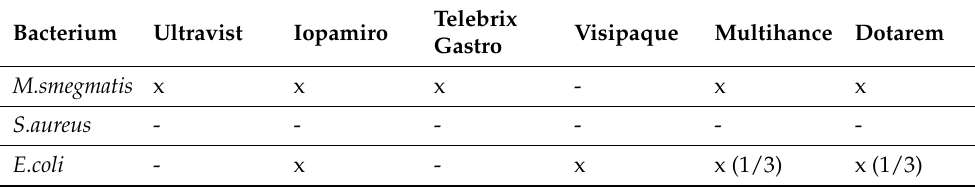
Table 2. Growth of bacteria in minimal medium M9 in the presence of contrast medium. Telebrix Bacterium Ultravist Iopamiro Visipaque Multihance Dotarem Gastro M.smegmatis x x x - x x S.aureus - - - - - - E.coli - x - x x (1/3) x